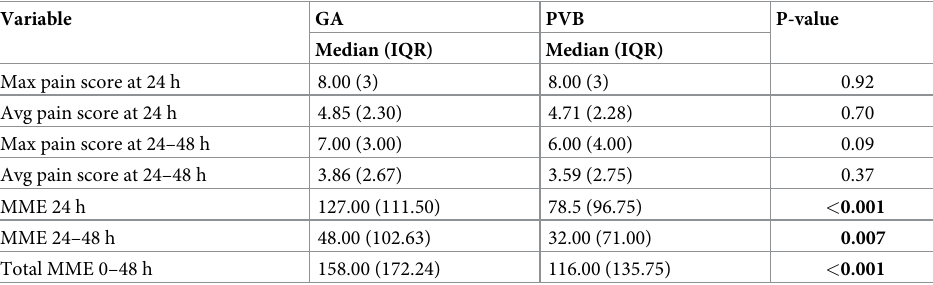
Table 3. Postoperative pain scores and opioid requirements.